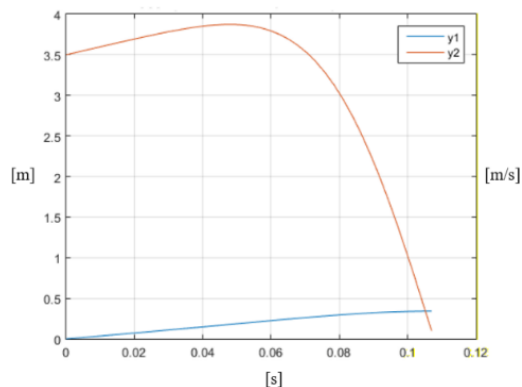
Figure 11. Displacement (blue line) and velocity of the buffer (orange line) at an operating temperature of +15 °C, an impact speed of v 0 = 3.5 m/s, and 𝜂 𝐶𝑇 = 0.4 . Figure 12 gives the change of dynamic force 𝐹(𝑥, 𝑥̇) , as expressed by Equation (7). The displacement and velocity of the movable system (Equation (7)) of the buffer (Equation (8)), for a working temperature of −60 °C and initial velocities v 0 = 1.15 m/s and v 0 = 3.5 m/s, are shown in Figures 13 and 14, respectively.